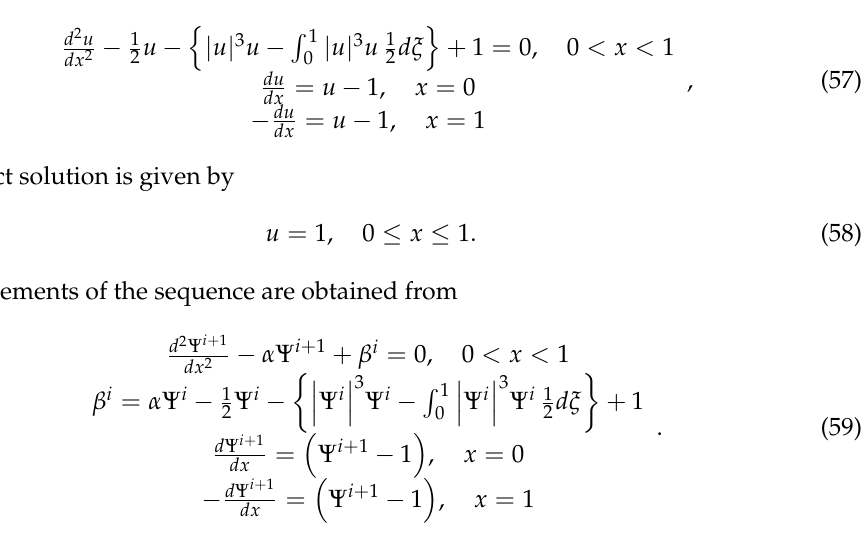
not be achieved.